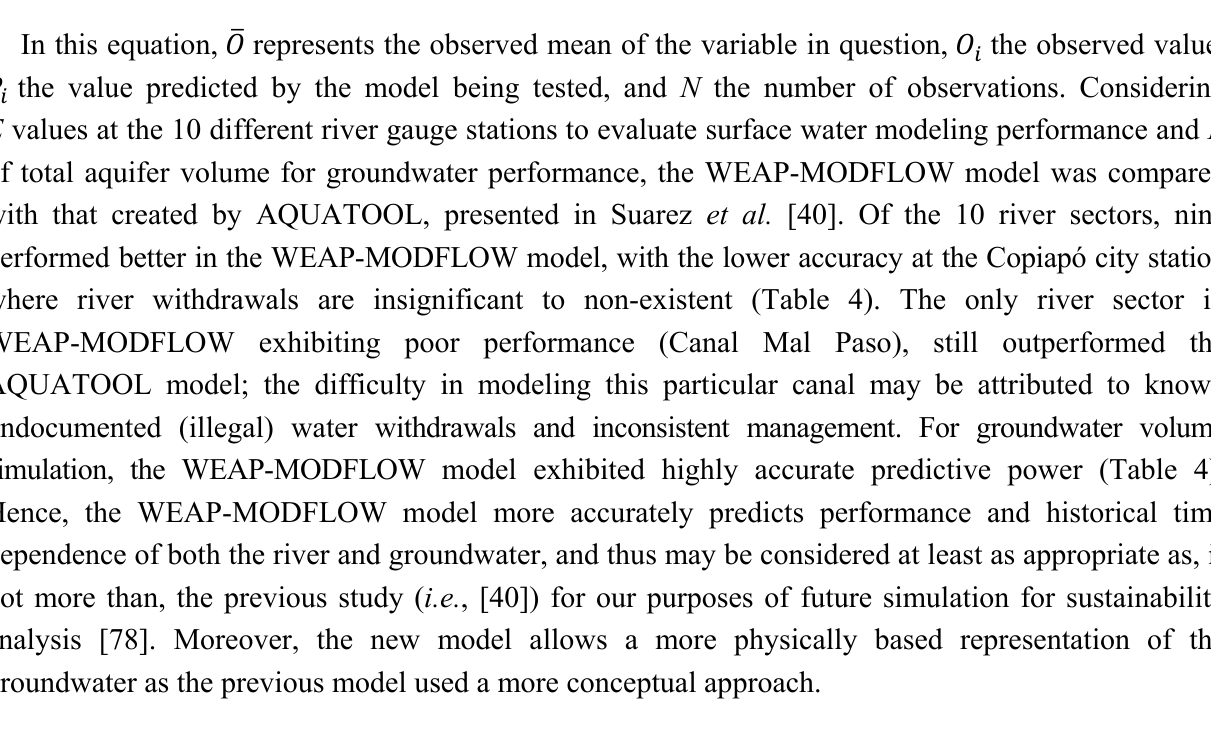
Table 4. Comparative calibration, Nash-Sutcliffe, and (cid:1843)(cid:3364) ; stream flow and aquifer